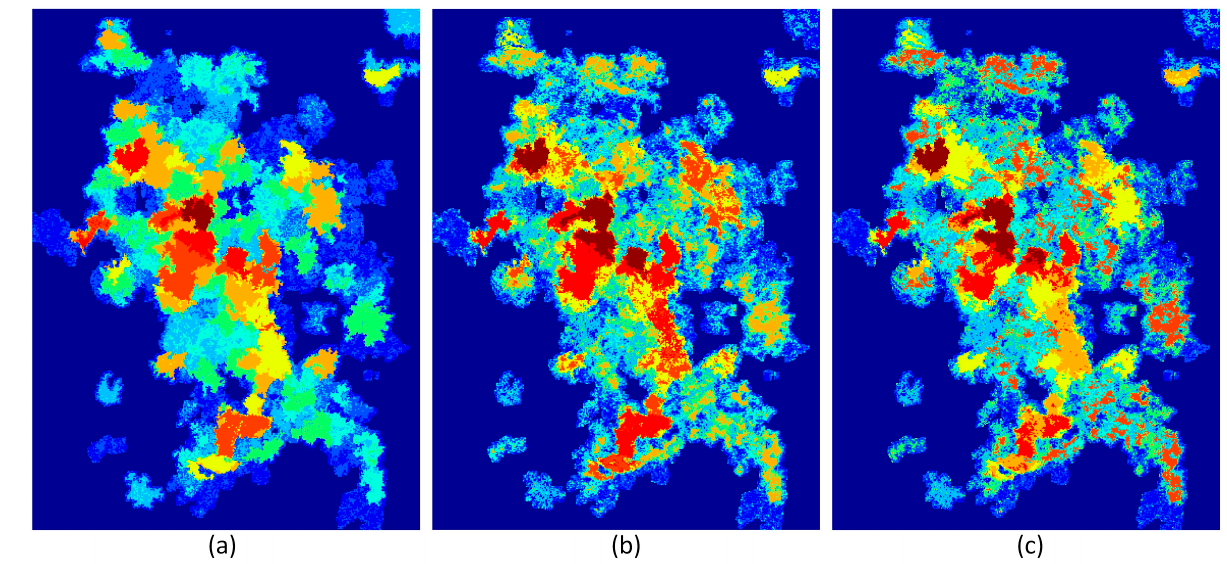
Figure 5. FCM segmentation of salient regions into 10 clusters using ( a ) VV, ( b ) VH, and ( c ) both polarizations as input.